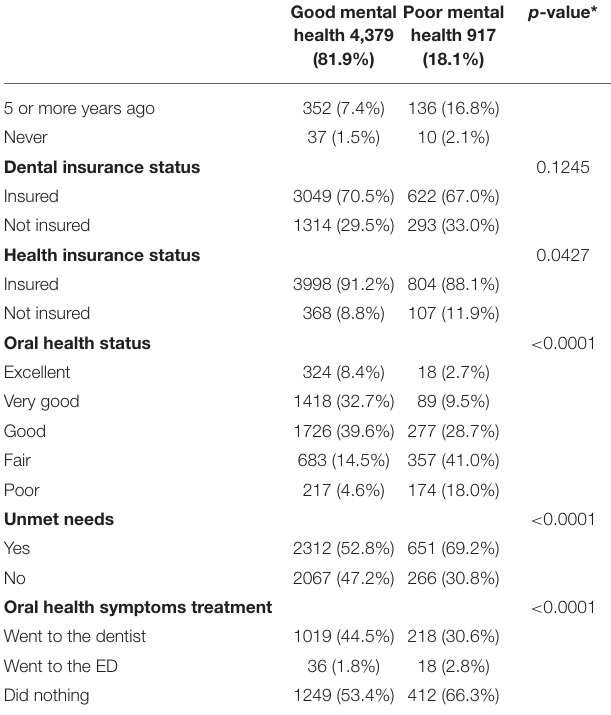
TABLE 1 | Mental health and COVID from the State of Oral Health Equity Survey 2021 ( n =